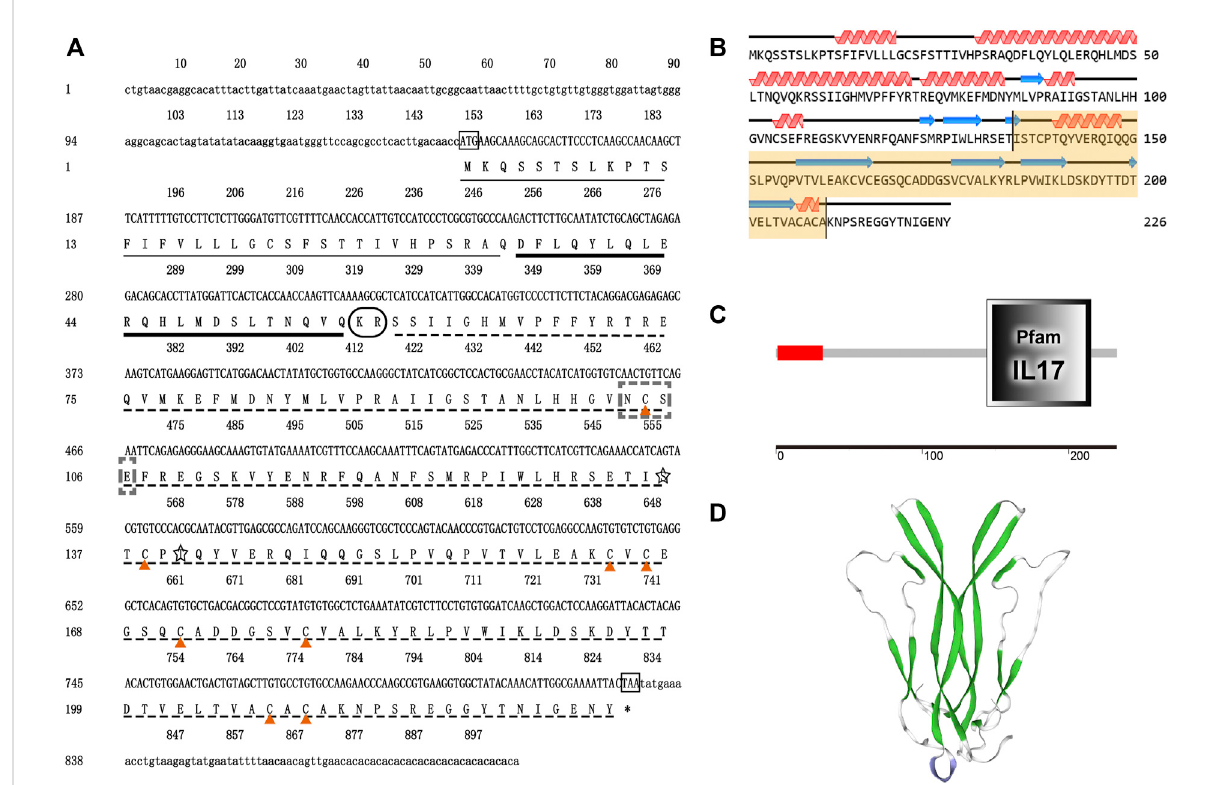
FIGURE 1 The basic molecular characterization of EsCFSH-1 (A) the nucleic acids and deduced amino acids sequence of EsCFSH-1 from the Eriocheir sinensis .The ORFwasshowninasingle lettercodebelowthenucleotidesequence.TheN-terminal glycosylationsitewasboxedinthedashed-line, theO-terminalglycosylationsitewassurroundedbytheshadedstars,thecysteineresidueswerepointedbytheorangetriangles.Theputativesignal peptide was underlined by the thin black line, the pre-CFSH related peptide was marked by the thick black line, and the CFSH mature peptide was marked by the black dashed line (B) the secondary structure of EsCFSH-1 protein predicted by Novopro. The predicted interleukin-17 domain was highlighted in yellow area (C) the predicted protein domain by the SMART. The red box was the signal peptide, and the dark frame was the interleukin-17 domain (D) the tertiary protein structure of EsCFSH-1 predicted by the